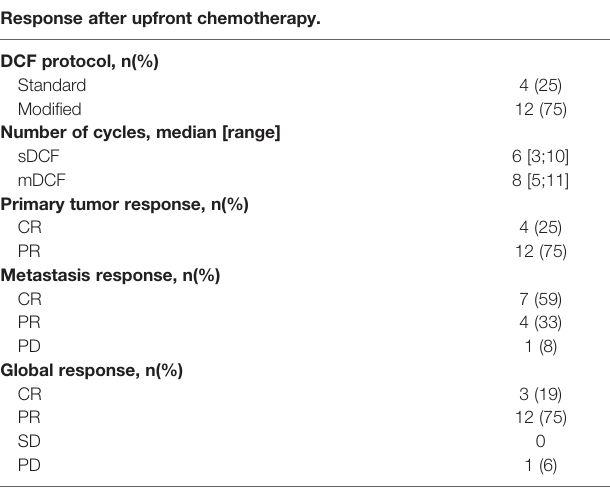
TABLE 2A | Response and toxicities after upfront chemotherapy. Response after upfront